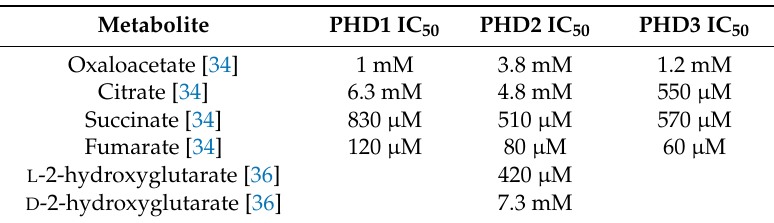
Table 1. Published IC 50 values of TCA cycle metabolites and 2-hydroxyglutarate (2-HG) enantiomers as inhibitors of HIF prolyl hydroxylases PHD1, PHD2 and